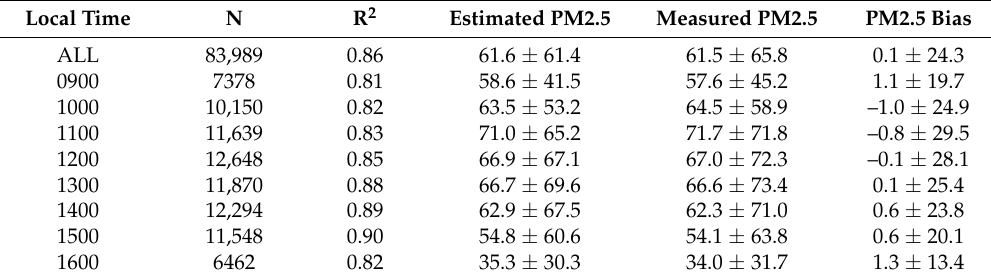
Table 7. Averages of estimated and measured PM2.5 at different hours.